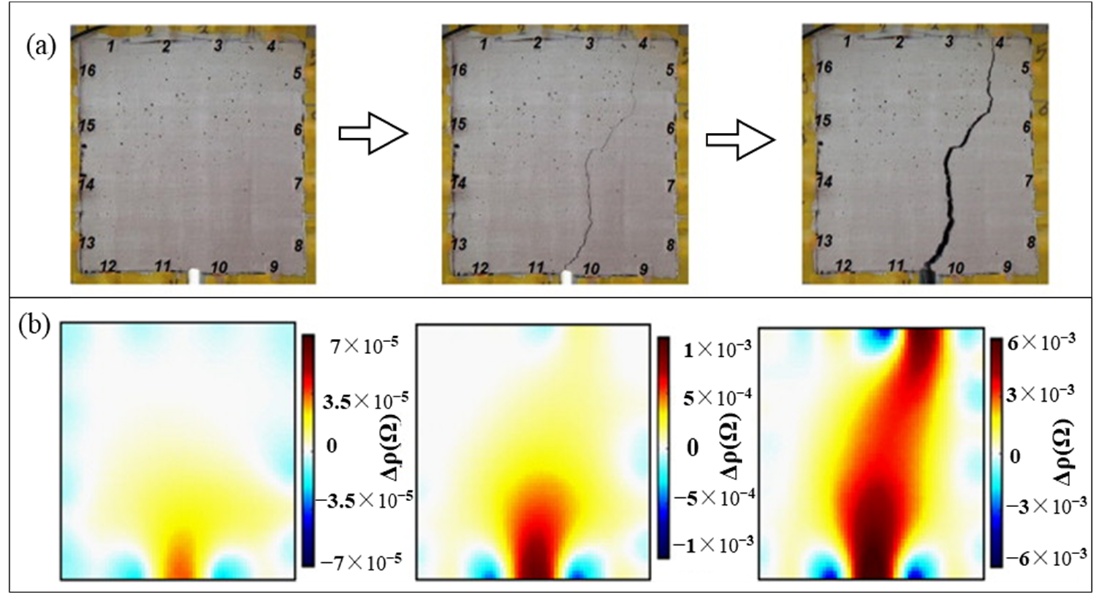
Figure 9. ( a ) crack expansion process of concrete square slab, ( b ) corresponding electrical resistance tomography of sensing skin under for crack detection [147] (Copyright 2014, Elsevier Ltd.).